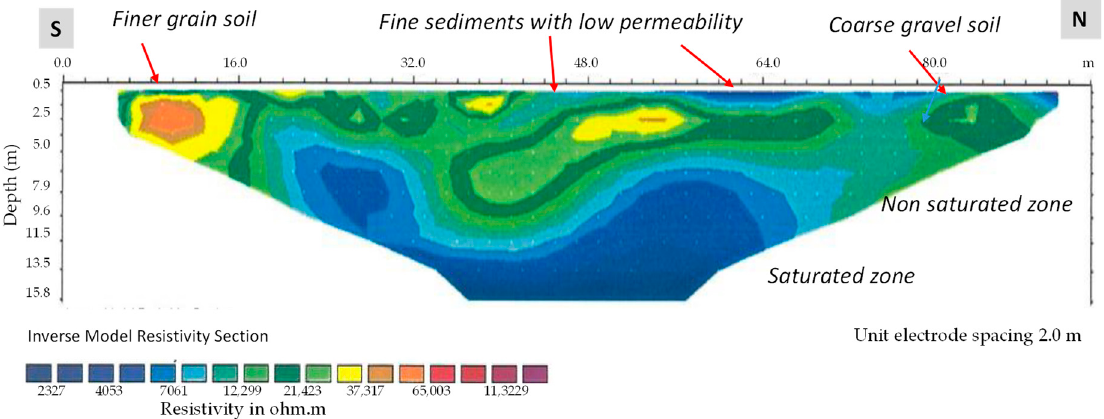
Figure 4. Interpreted Electrical Resistivity Profile (ERT) PE 1. Look at Figure 3 for profile